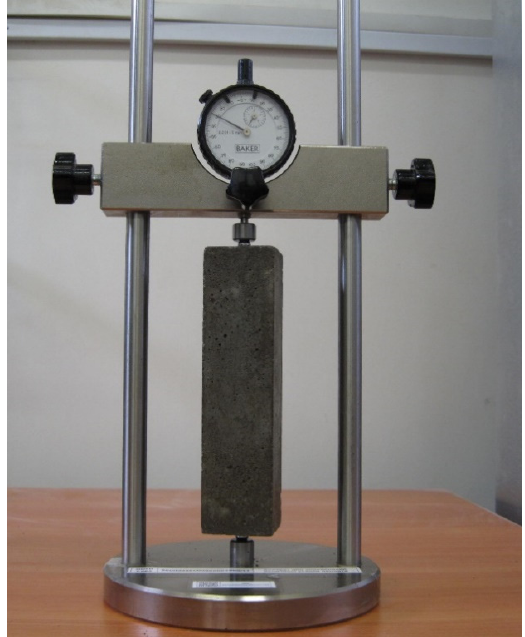
Figure 1. Device for measuring sample deformation.